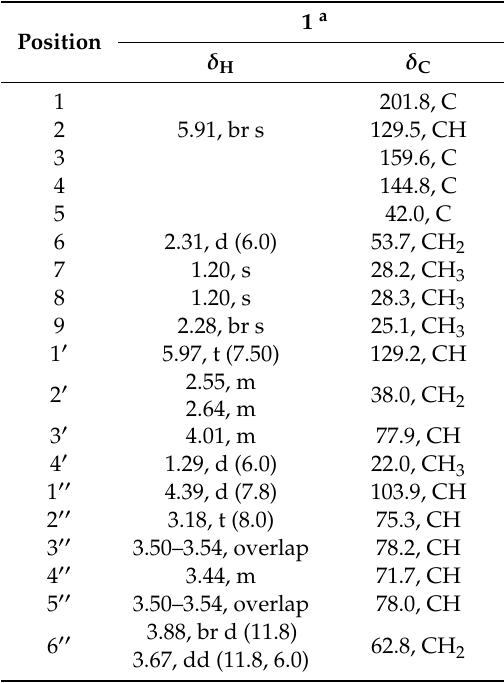
Table 1. 1 H and 13 C NMR spectral data for compound 1 ( δ in ppm, J in Hz).